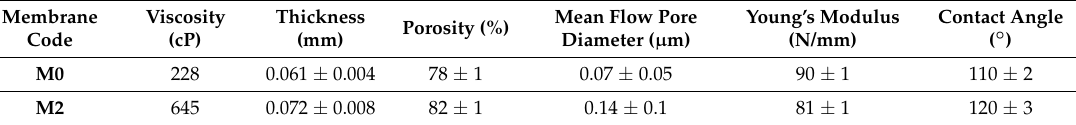
Table 3. Characterization of membranes prepared without and with additives.